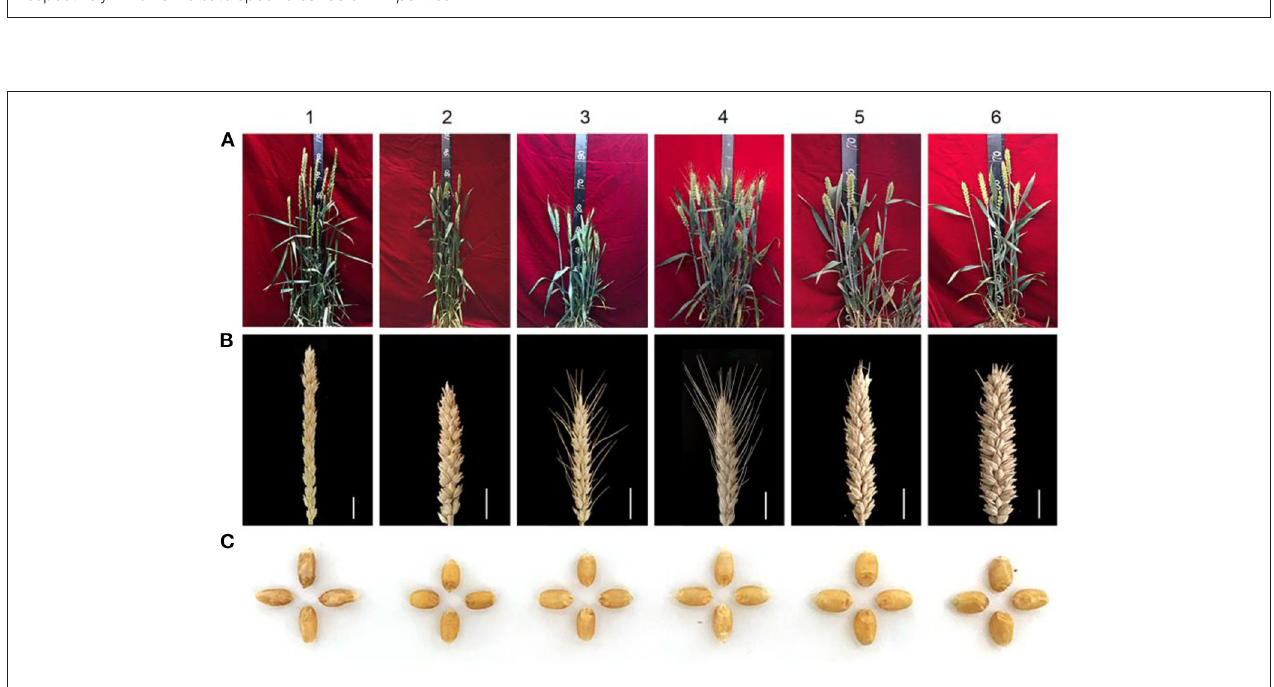
FIGURE 7 | Plants, spikes, and kernels of SN0293-2, SN0293-7, and their parents. (A) Plants. (B) Spikes. (C) Kernels. 1–6 refer to SNTE20, YN15, SN224, JM22, SN0293-2, and SN0293-7, respectively. Scale bar = 2cm.